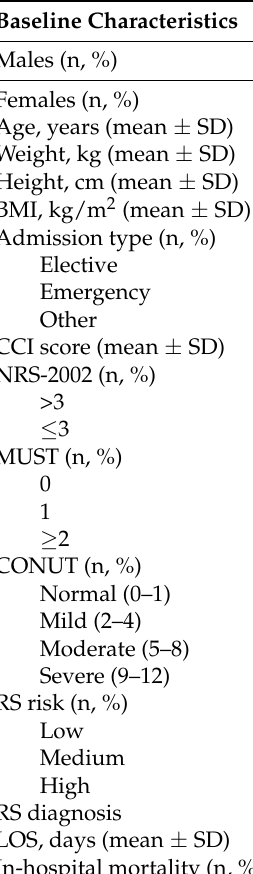
Table 2. Patients’ baseline characteristics (n =